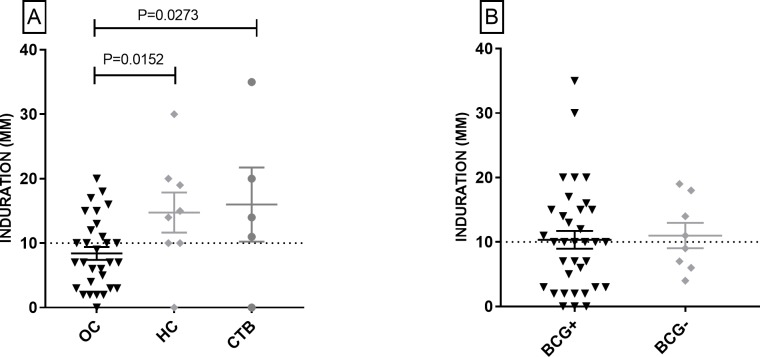
Response of HCWs to TST.[A] Responses (skin induration) of household contacts (HC) and cured TB patients (CTB) were significantly stronger than the occupational contacts (OC), and [B] responses of subjects with (+) or without (-) BCG scar were comparable. Mean +/- SEM of values in each column are depicted and P values are shown on top of corresponding columns. Dashed horizontal lines denote cut-off for a positive response (= 10 mm induration).